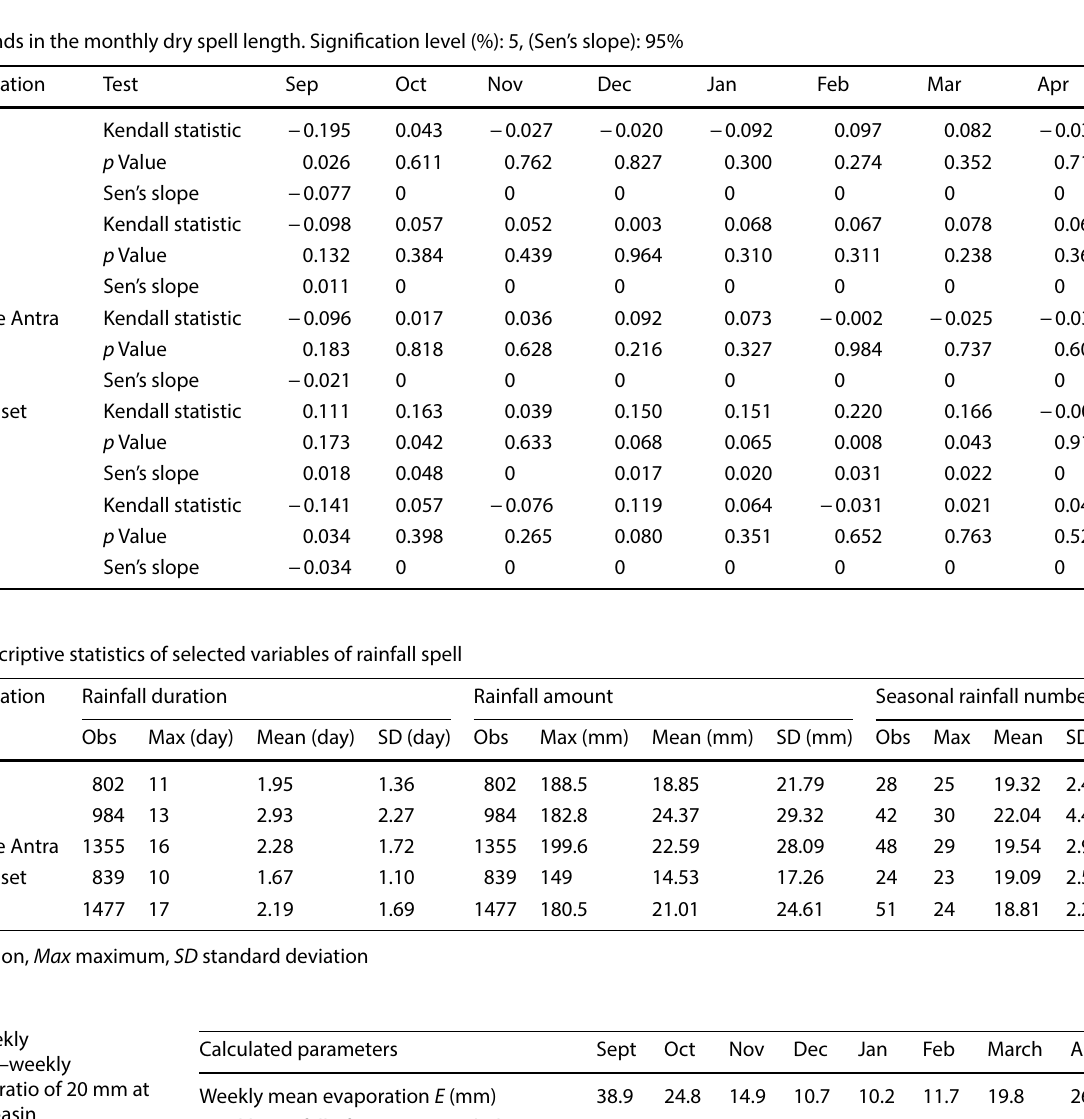
Table 12 Weekly evaporation—weekly precipitation ratio of 20 mm at Ichkeul lake basin